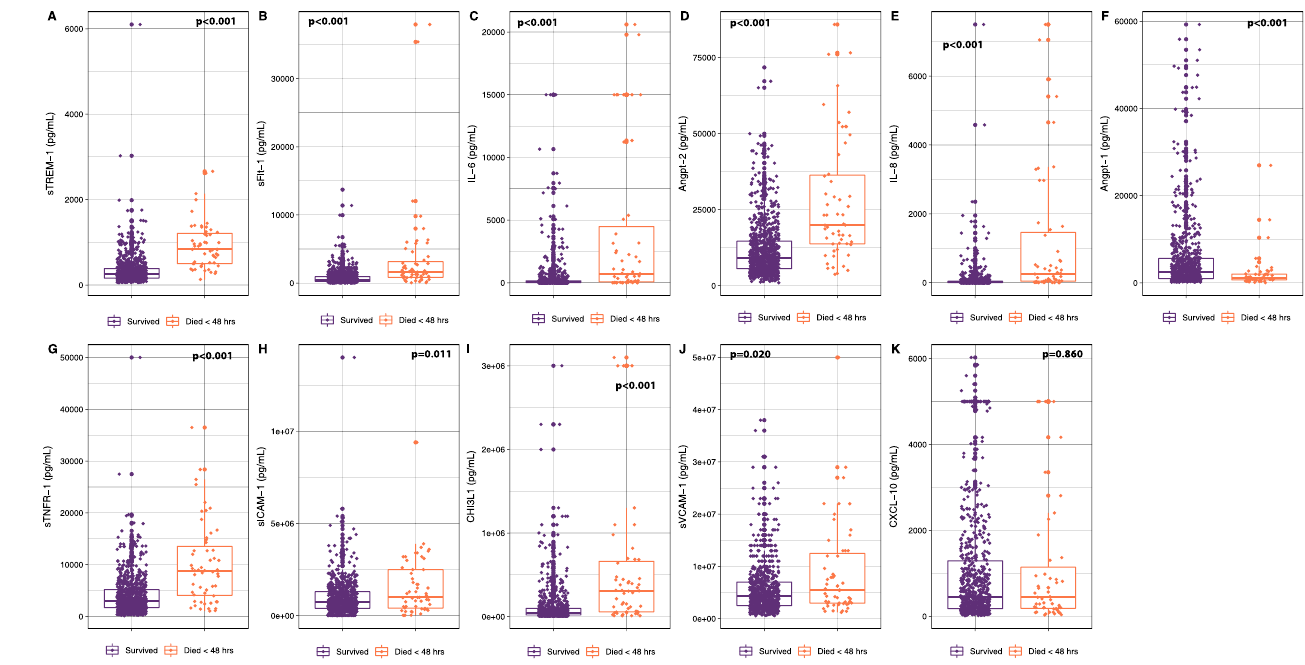
Fig 1. Plasma concentrations of immune and endothelial activation markers in children with IMCI pneumonia who died within 48 hours of hospital admission compared with those who survived. Plasma concentration of (a) sTREM-1 ( P < 0.001), (b) sFlt-1 ( P < 0.001), (c) IL-6 ( P < 0.001), (d) Angpt-2 ( P < 0.001), (e) IL-8 ( P < 0.001), (f) Angpt-1 ( P < 0.001), (g) sTNFR-1 ( P < 0.001), (h) sICAM-1 ( P = 0.011), (i) CHI3L1 ( P < 0.001), (j) sVCAM-1 ( P < 0.020), (k) CXCL-10/IP-10 ( P = 0.860). Angpt-1, angiopoietin-1; Angpt-2, angiopoietin-2; CHI3L1, chitinase-3-like-1 protein; IL-6, interleukin-6; IL-8, interleukin-8; IMCI, Integrated Management of Childhood Illness; IP10/CXCL-10, interferon-gamma-inducible protein-10/c motif chemokine 10; sFlt-1, soluble fms-like tyrosine kinase-1; sICAM-1, soluble intracellular adhesions molecule-1; sTNFR-1, soluble tumor necrosis factor receptor-1; sTREM-1, soluble triggering receptor expressed on myeloid cells-1; sVCAM-1, soluble vascular cell adhesion molecule-1.